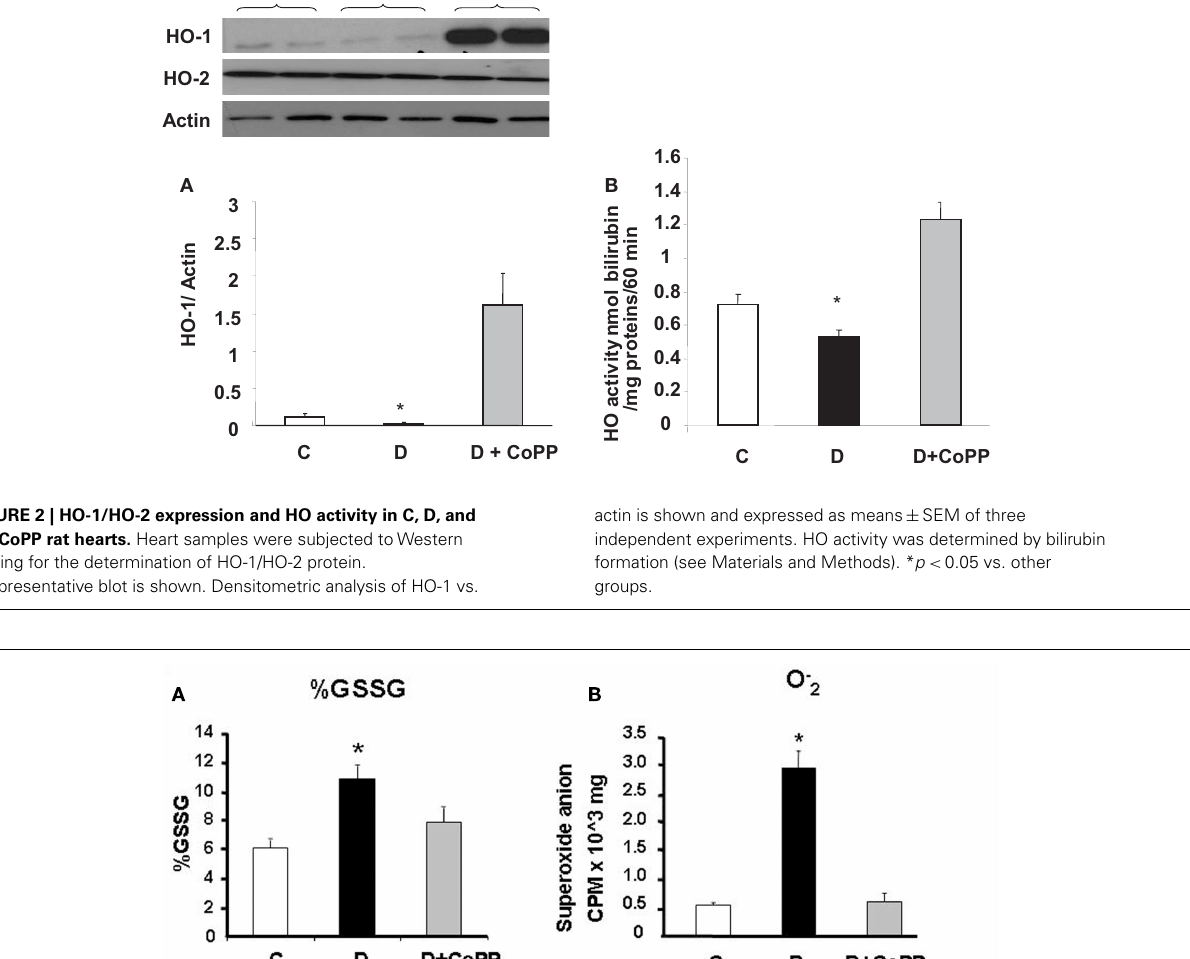
Western blot and densitometric analysis of 3-nitrotyrosine (3-NT) expression in FIGURE 3 | Cardiac tissue levels of (A) % GSSG cardiac tissue of C, D, and D+CoPP rats. Data are expressed as means ± SEM [GSSG/(GSH + GSSG) × 100], (B) O − and (C) malonyldialdehyde (MDA) 2 , of three independent determinations * p < 0.05 vs. other measured in hearts from C, D, and D + CoPP rats. (D) Representative